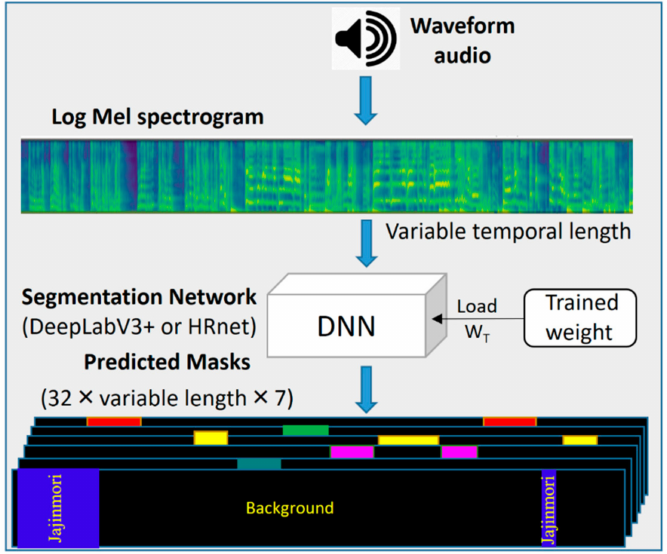
Figure 1. Information pipeline in inference phase of semantic segmentation of Pansori rhythm. The black color represent background and the music rhythmic segments are shown by unique color in the temporal direction of music in spectral